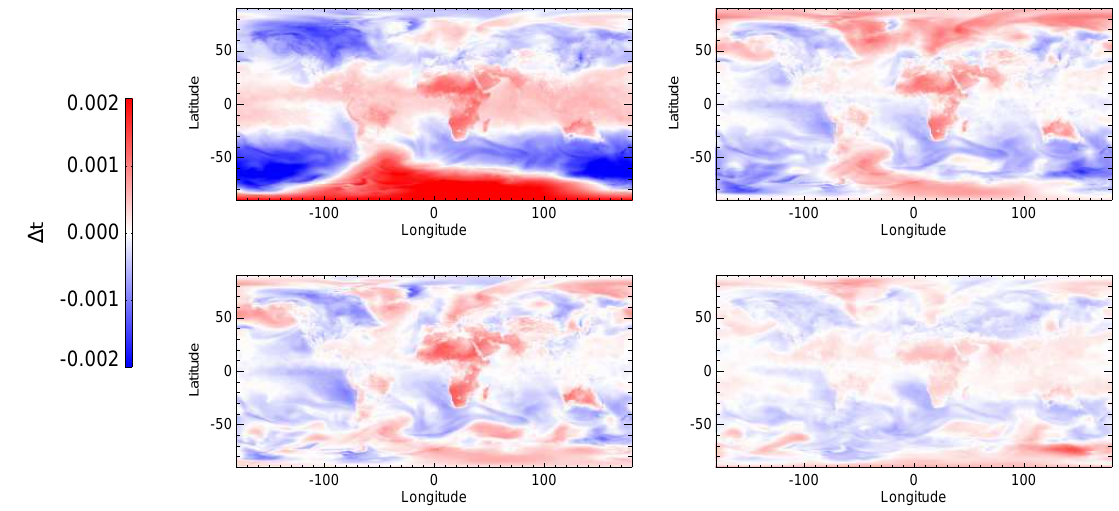
Fig. 5. Global distribution of bias of approximated transmittance t ∗